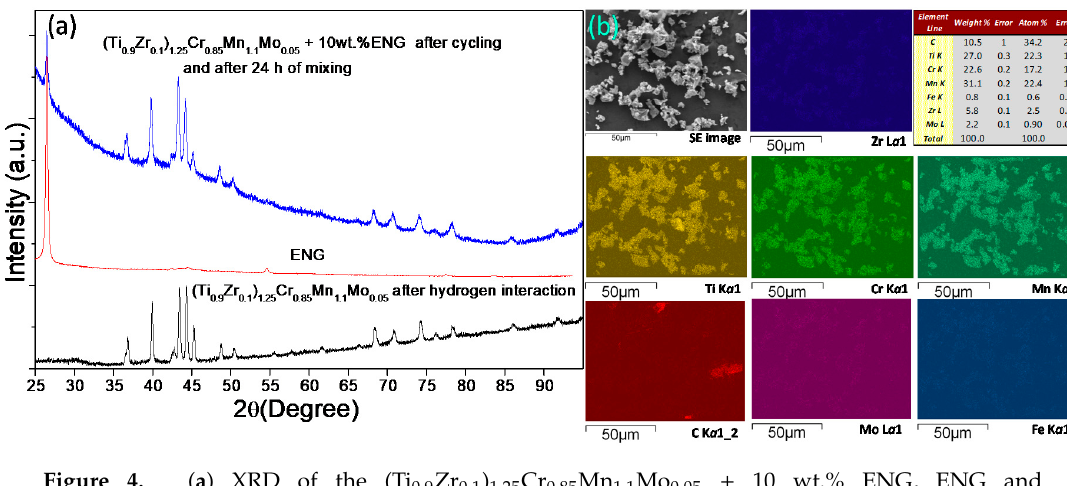
Figure 4. ( a ) XRD of the (Ti 0.9 Zr 0.1 ) 1.25 Cr 0.85 Mn 1.1 Mo 0.05 + 10 wt.% ENG, ENG and (Ti 0.9 Zr 0.1 ) 1.25 Cr 0.85 Mn 1.1 Mo 0.05 after hydrogen interaction. ( b ) SEM photo, EDS mapping, and EDS analysis for the (Ti 0.9 Zr 0.1 ) 1.25 Cr 0.85 Mn 1.1 Mo 0.05 + 10 wt.% ENG in powder form after hydrogen cycling.